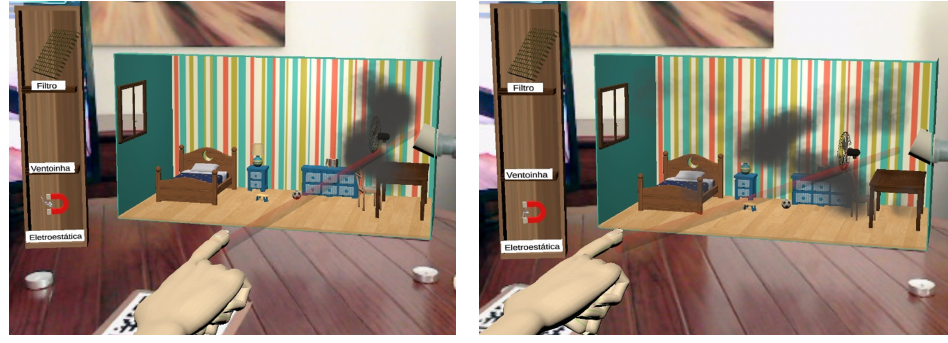
Figure 8. Interaction using the fan tool.